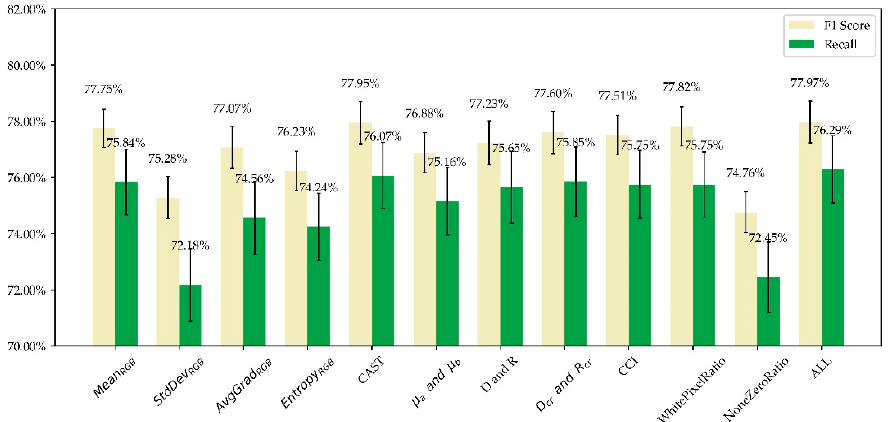
Figure 6. Results of ablation study. Features were removed groups by groups. The results are the mean values obtained through 300 times of tests, and the black vertical disconnections indicate ± standard deviation. The results of all the features are plotted on the right. F1 score and recall fall down more or less when any group of features is removed.